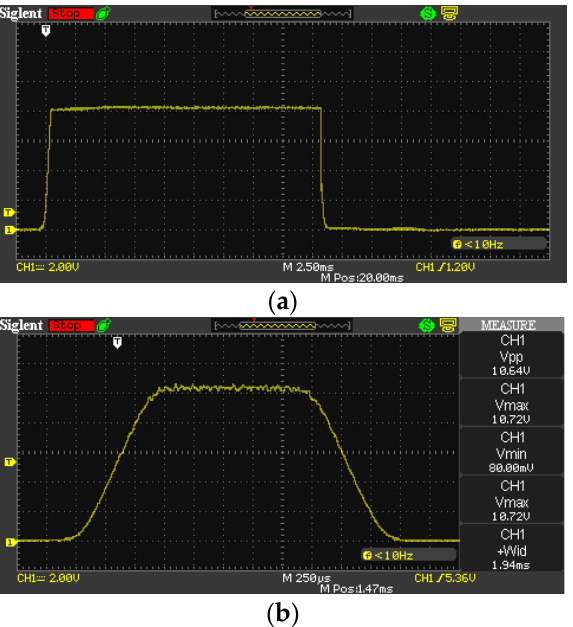
Figure 4. Measurements of C1 using the direct method. Settings: ( a ) 1/30 s, ( b ) 1/500 s.